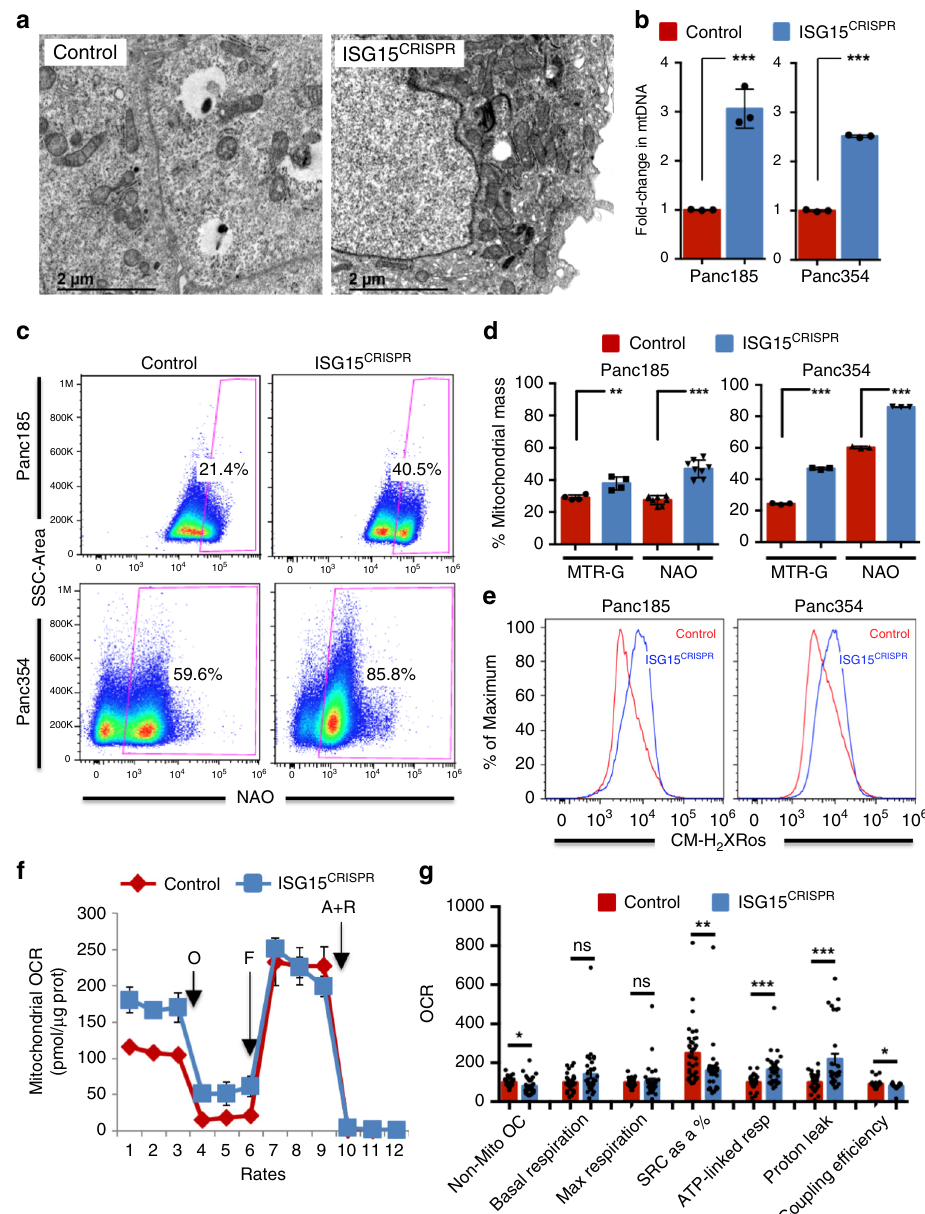
Fig. 4 Loss of ISG15/ISGylation alters mitochondrial state and metabolism. a Transmission electron micrographs of control and ISG15 CRISPR Panc185 cells. Scale bars = 2 µ M. b RTqPCR analysis of fold-change in mitochondrial DNA (mtDNA) gene 12s mean copies ± sd in control and ISG15 CRISPR Panc185 and Panc354 cells. Data are normalized to β -Actin expression and control set as 1.0. ( n = 3 biologically independent samples; *** p < 0.0001, as determined by Student ’ s t -test). c , d Representative histograms of fl ow cytometric analysis of NAO (10-N-Nonyl acridine orange) in control and ISG15 CRISPR Panc185 and Panc354 cells c , and mean percentages ± sd in mitochondrial mass as a function of Mitotracker Green (MTR-G) and NAO (10-N-Nonyl acridine orange) staining d (Panc185: MTR-G n = 4 biologically independent samples ** p = 0.0092 and NAO n = 8 biologically independent samples *** p < 0.001, as determined by Student ’ s t -test; and Panc354: MTR-G and NAO n = 3 biologically independent samples *** p < 0.001, as determined by Student ’ s t -test). e Representative histograms of Mitotracker CM-H 2 XRos in control and ISG15 CRISPR Panc185 and Panc354 cells. f Representative plot of mean Oxygen Consumption Rate (OCR) levels± sem, normalized to protein content, for control and ISG15 CRISPR Panc185 cells, which were treated with O (oligomycin),